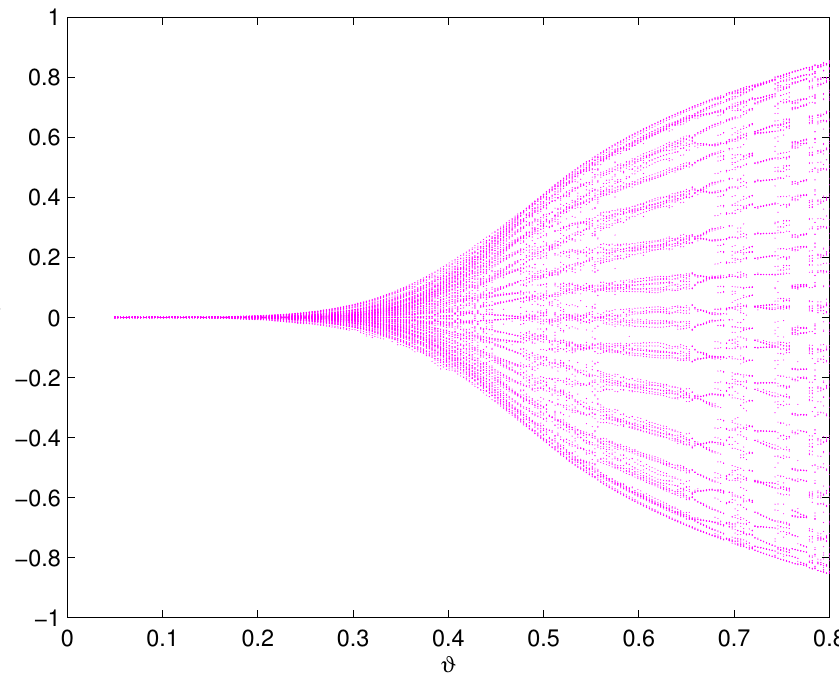
Figure 14. Bifurcation graph of system (72): the time delay ϑ versus the variable w 5 . The bifurcation number is